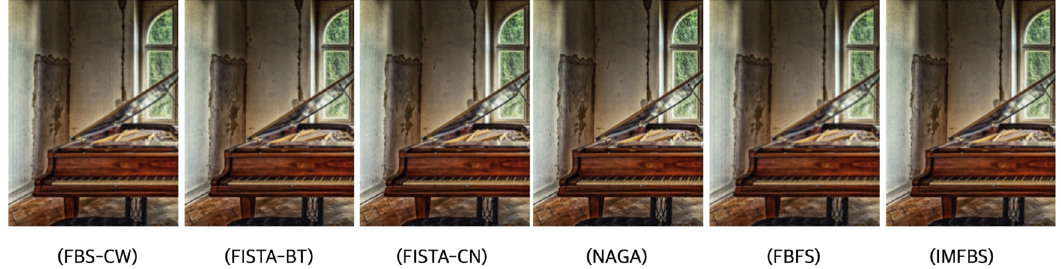
Figure 4: The restored images by BM - 1.2 for FBS - CW ( PSNR:29.5205, SSIM:0.8996 ) , FISTA - BT ( PSNR:40.6212, SSIM:0.9765 ) , FISTA - CN ( PSNR:41.9730, SSIM:0.9833 ) , NAGA ( PSNR:41.5473, SSIM:0.9813 ) , FBFS ( PSNR:28.0377, SSIM:0.8717 ) , and IMFBS ( PSNR:44.4942, SSIM:0.9901 ) ,